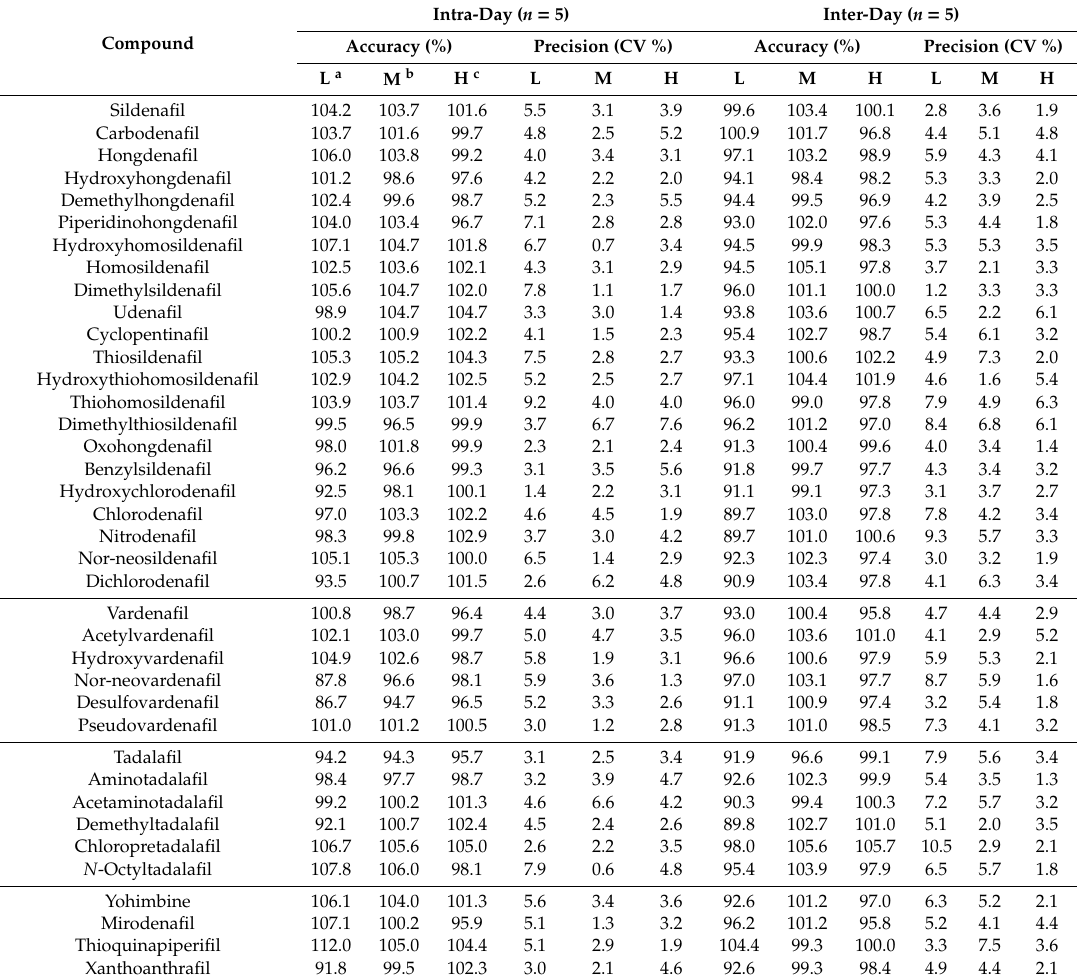
Table 3. Intra- and inter-day accuracy and precision of PDE-5 inhibitors and their analogs. Compound